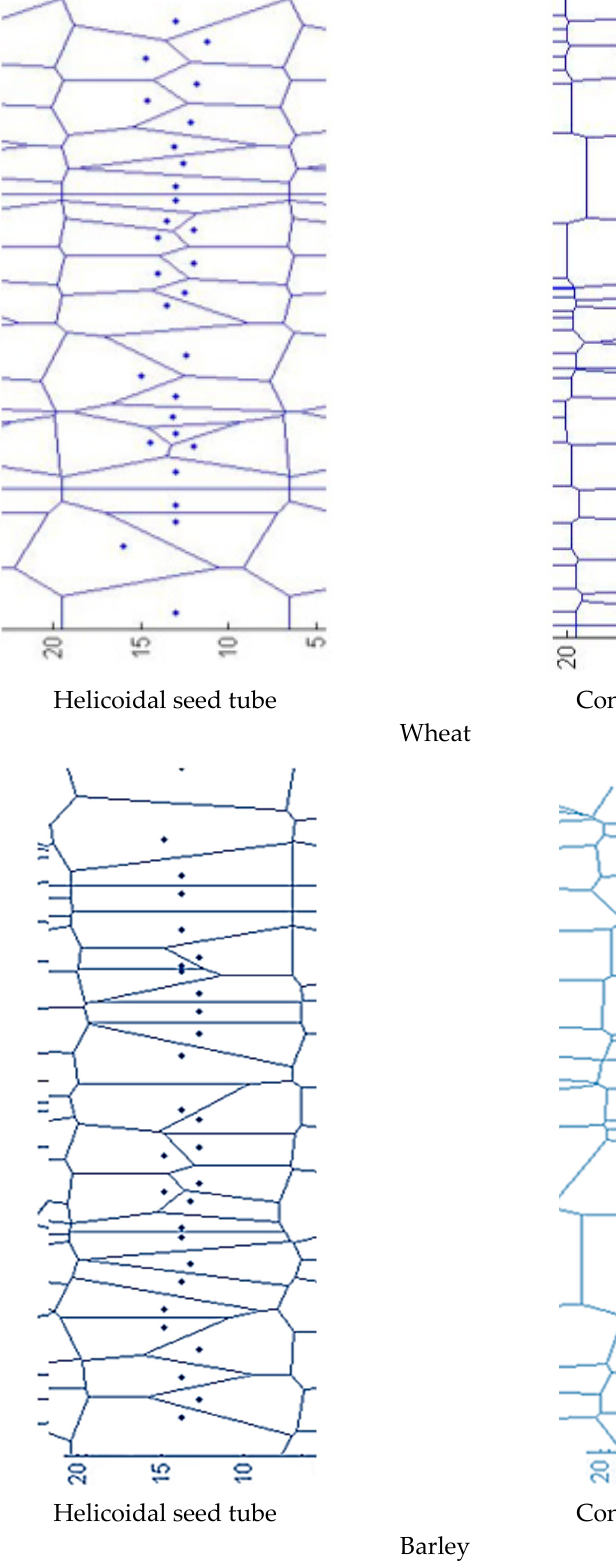
Figure 5. Growing area distribution for each plant.